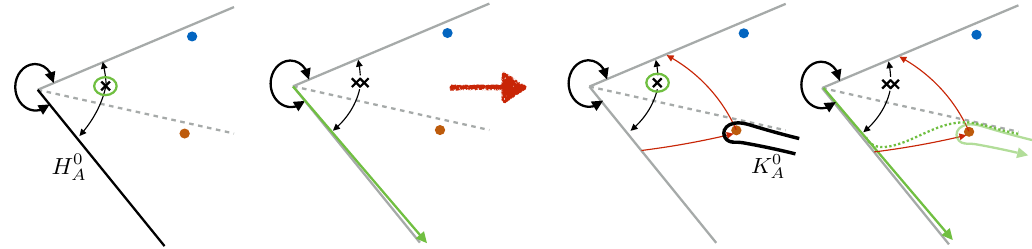
Figure 6 . The complex λ plane represented as a slice of pie with the edges identified. Note that λ is an anti-holomorphic coordinate so ordering is now anti-clockwise compared to the discussion in the text. The green curves are the contours we integrate over. The two figures on the left represent the two terms in (4.18) and on the right we have the two terms C (1 , 2)